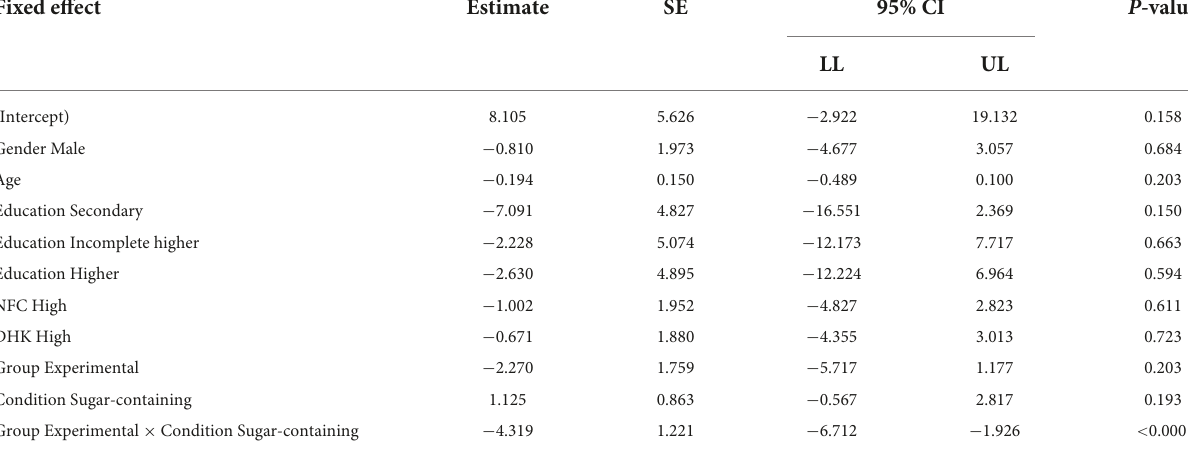
TABLE 1 Linear mixed effects model for predicting the delta of WTP with subject-level random